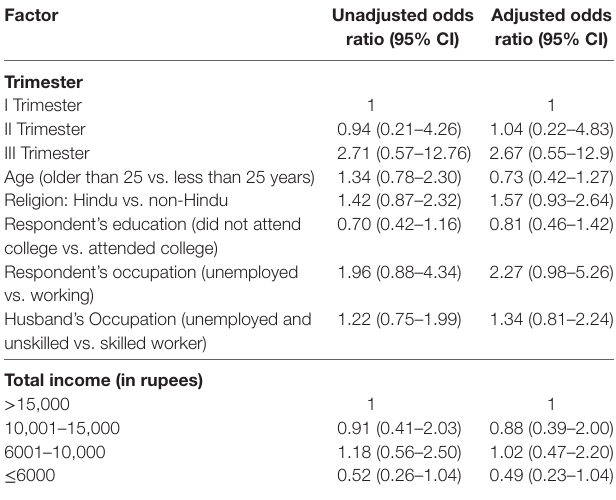
TaBle 3 | Multivariate analysis of sociodemographic risk factors and mental distress in